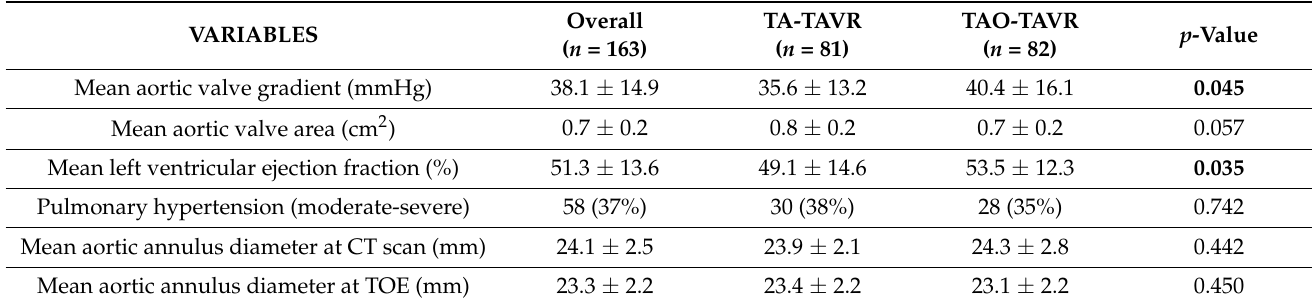
Table 2. Preoperative echocardiographic findings and CT scan